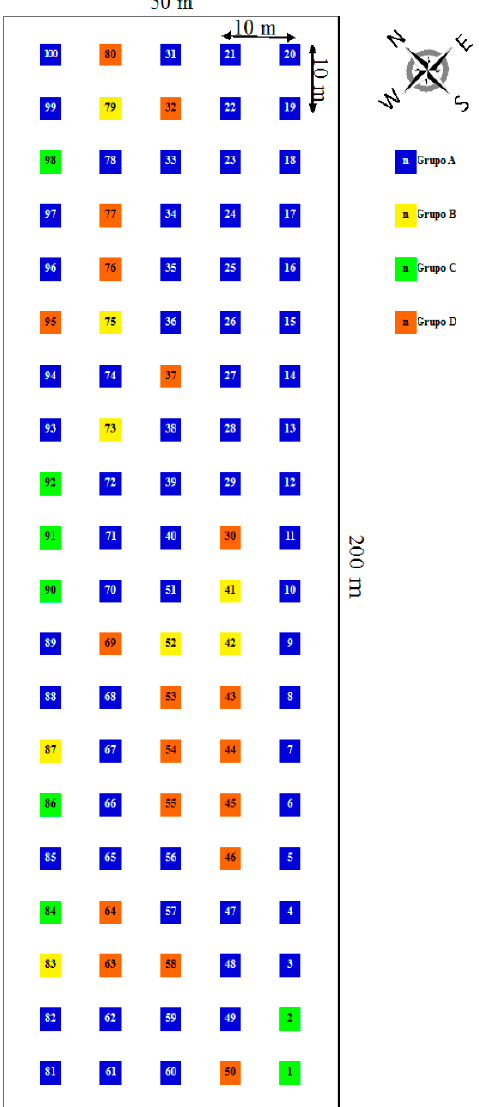
Figure 4. Spatial distribution of different individuals of Cistus ladanifer sampled, n: individual ( n = 100).